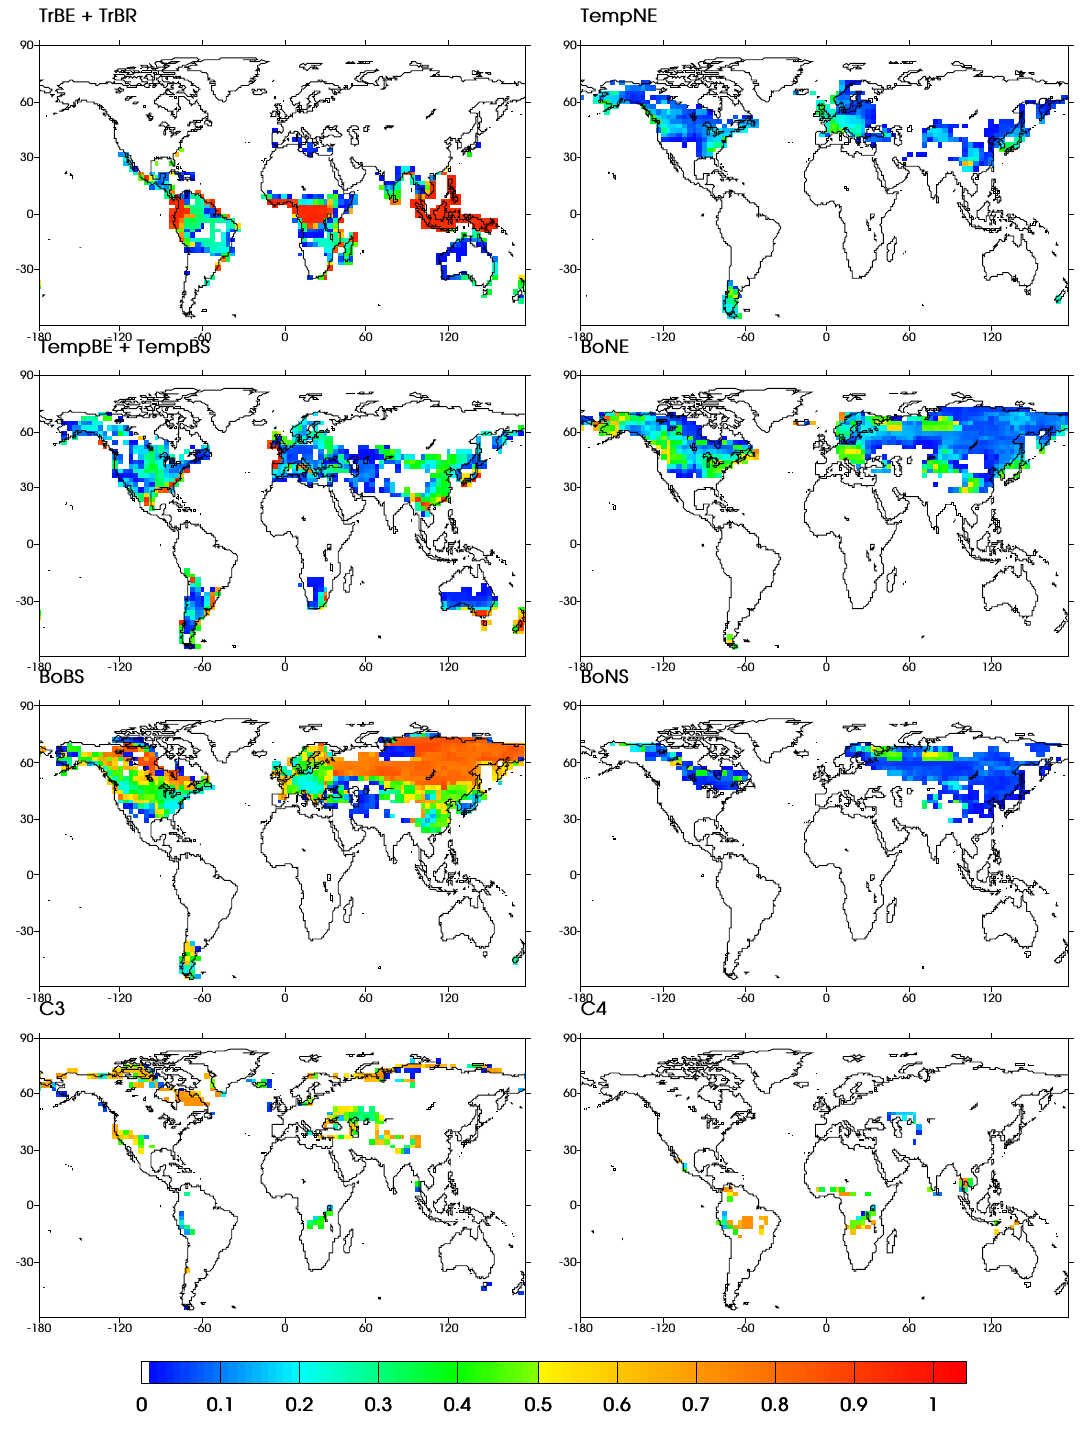
Fig. 4. Fractions of vegetation (annual maximum, in % of grid-cell) simulated by ORCHIDEE in CTRLP (present-day climate and modern CO 2 for photosynthesis). Abbreviations: see Table